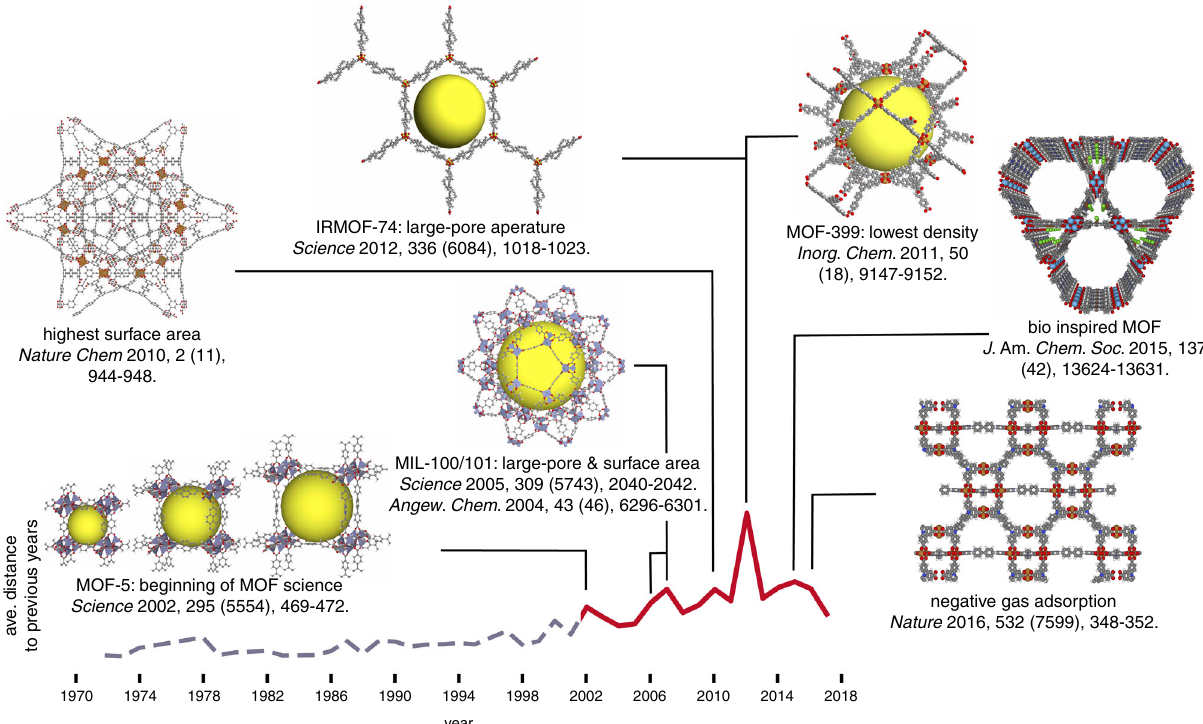
Fig. 6 Timeline of evolution of MOF geometry. For each year, the average of relative distance in the geometry descriptor space to the MOFs reported in Cambridge structural database (CSD) 26 in the preceding years is shown with red line. The MOFs with largest distance for some of the peaks are shown in the inset 5,49 – 53,68,69 . The years on the timeline are corresponding to the year that a structure has been deposited in CSD. The grey line shows the coordination polymers reported in CSD before the beginning of the MOF chemistry as a separate fi eld of research, shown in